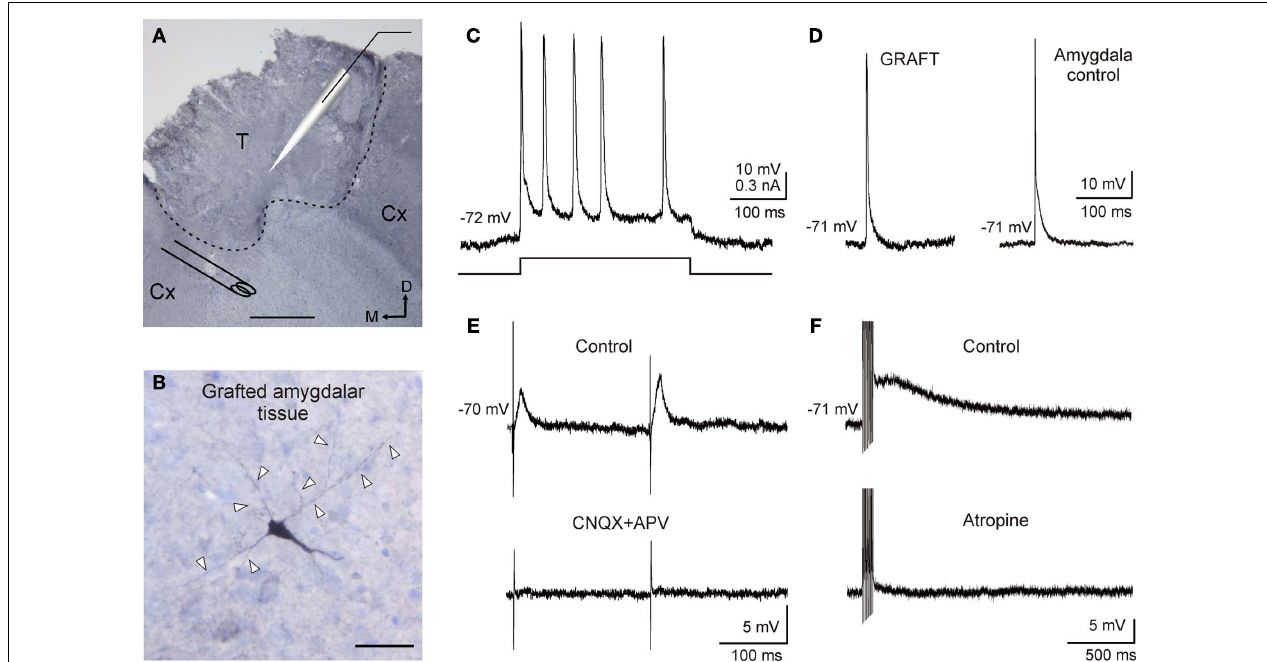
neurons recorded by using sharp electrodes during injection of supra-threshold depolarizing current pulses (0.3nA, 300ms) showed a regular spiking firing pattern. (D) Spontaneous action potential recorded from a neuron in the graft and a neuron in the basolateral amygdaloid complex. Note the responses similarity. (E) Graft-evoked synaptic current by adjacent host cortex stimulation. Explored neurons presented a facilitation (136 ± 22%) in EPSP amplitude evoked by the second stimulus (S2) presented to the host cortex in relation to the first (S1), at an interval of 50–100ms.These evoked responses were blocked by CNQX (10 μ M) and APV (50 μ M) perfusion. (F) Neuron recorded in the graft showing a sustained response to high frequency stimulation of adjacent cortex.This response was removed by atropine sulfate (1 μ M)